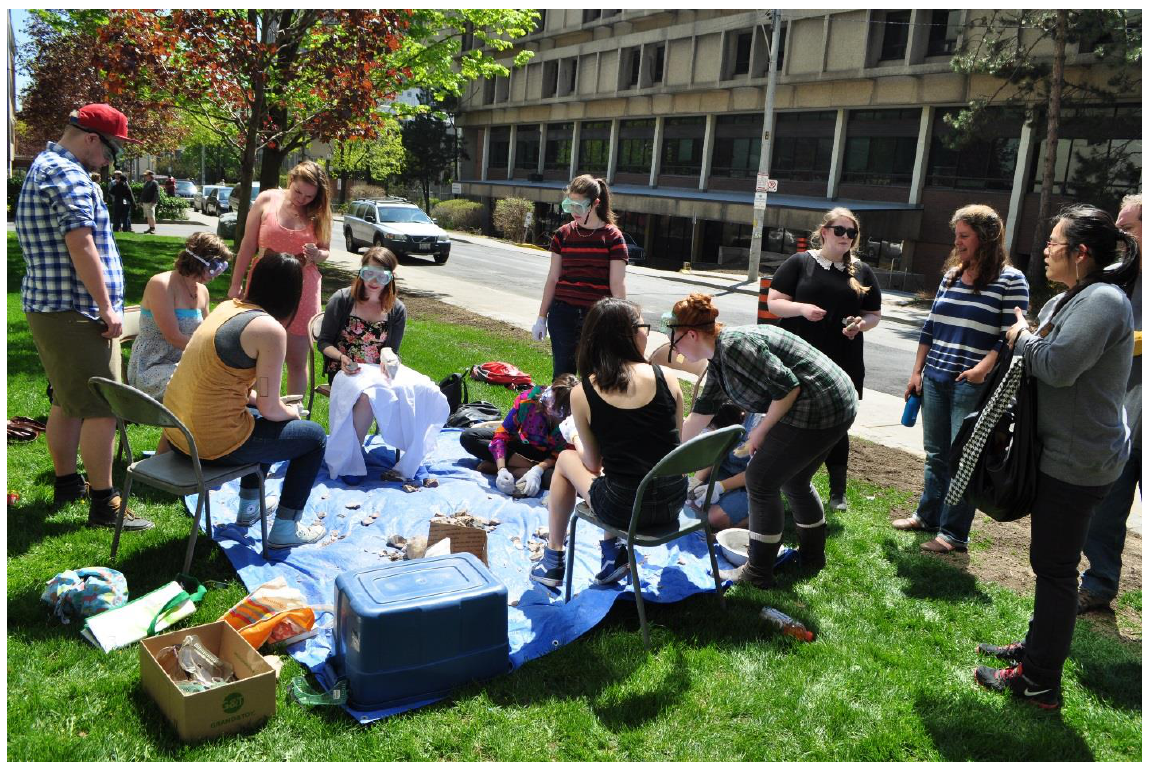
Figure 1. Students practice and learn flintknapping outside the Anthropology Building, University of Toronto (Photo: Paulina